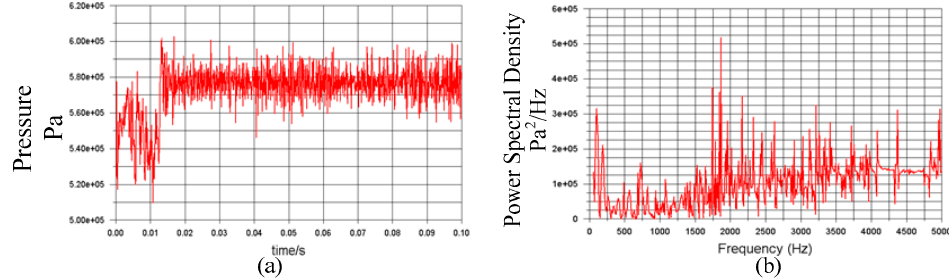
Figure 20. Pressure oscillation curve of the flapper considering the impression of the main valve and velocity of 10 m/s. ( a ) Time domain. ( b ) Frequency domain.